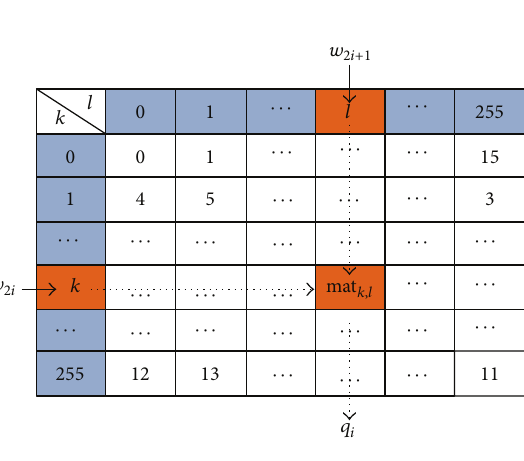
Figure 2: The proposed matrix.